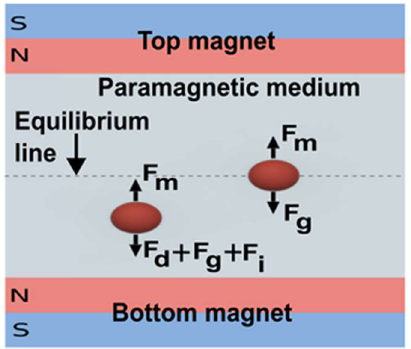
Figure 7. Scheme of diamagnetic levitation with a permanent magnet. ( F m = magnetic force, F g = Gravitational force, F d = drag force, F i = inertial force) (Adapted with permission from [96]. Copright 2015, WILEY-VCH Verlag GmbH & Co. KGaA, Weinheim)